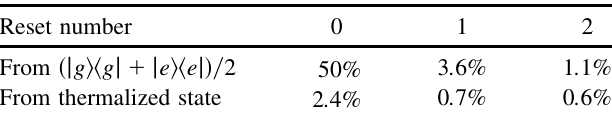
TABLE I. Error in the preparation of j g i using zero, one, or two resets by feedback when starting in the most entropic state or in the thermalized state (effectively at 46